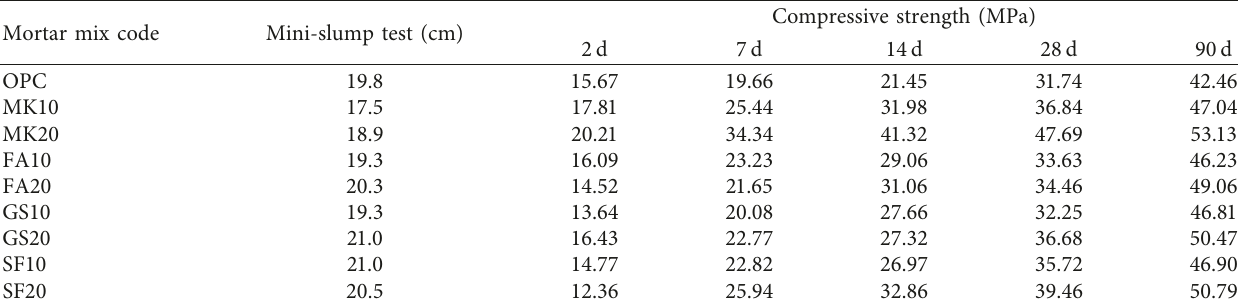
Table 4: Mini-slump test and compressive strength results of each mortar